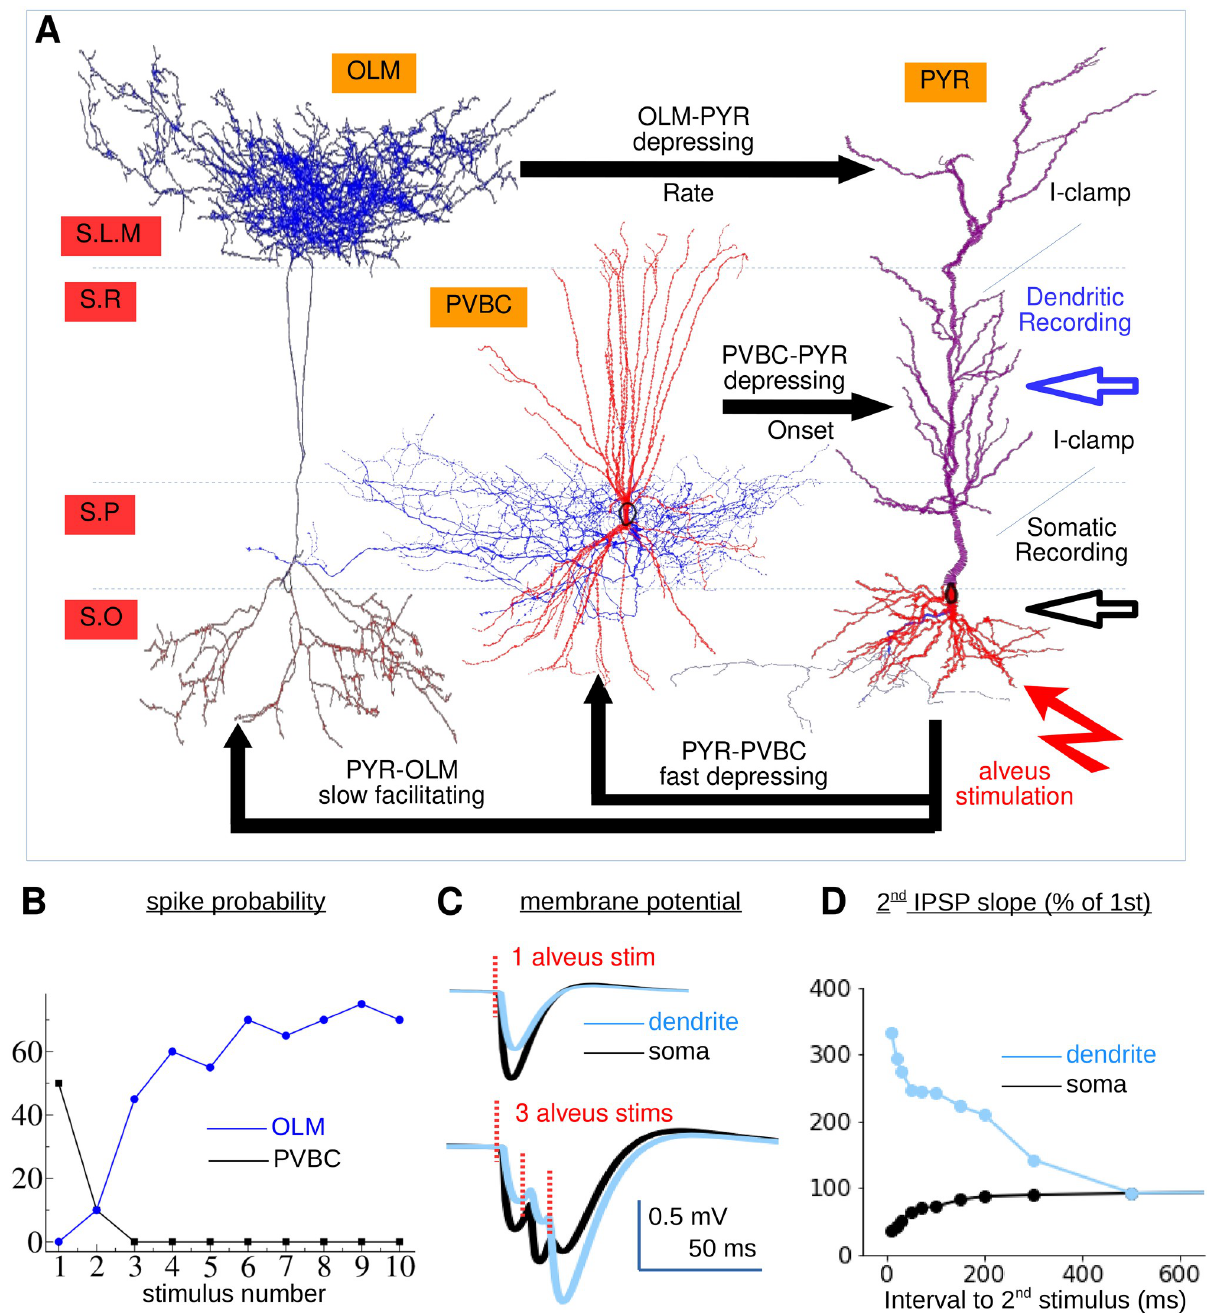
Fig 1. Model validation for comparison with experimental results in [69]. (A) Schematic of microcircuit configuration. PVBC cells target the PYR soma or dendrites within about 50 microns of the soma. OLM cells on the other hand target the PYR distal apical dendrites at least 250 microns from the soma. Cells are connected to random locations within the appropriate dendritic domains using the appropriate number of synapses per connection estimated from studies [70]. Feedforward connections are activated by alveus stimuli. Recording locations are indicated at PYR soma and at locations in the proximal region of the apical dendrite as in [69]. As in [69], the PYR cell was current clamped at the soma and at several places in the apical dendrite to amplify IPSPs . (B) PVBC and OLM (see key) spiking probability versus stimulus number. Values shown are averages across eighty cells with different random synaptic conductance parameters and alveus stimulus locations . (C) Membrane potential traces in the dendrite and the soma when the circuit is activated with a single alveus stimulus and three successive alveus stimuli at 100 Hz. Note that the dip in the experimental traces following each alveus stimulus is an artifact which should be ignored . (D) Dependence of successive IPSP size on interstimulus interval . (C,D) The GABA decay timescale from OLM to PYR cells used here is 18 ms [56, 71, 72].